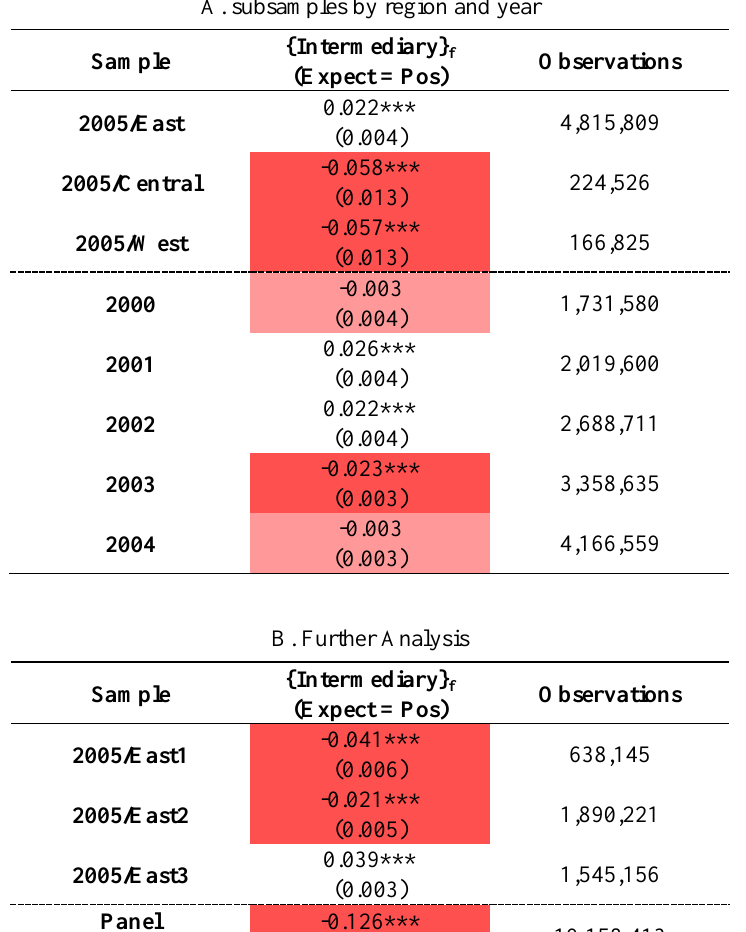
Table 5: Robustness check of AKW’s results: Prediction